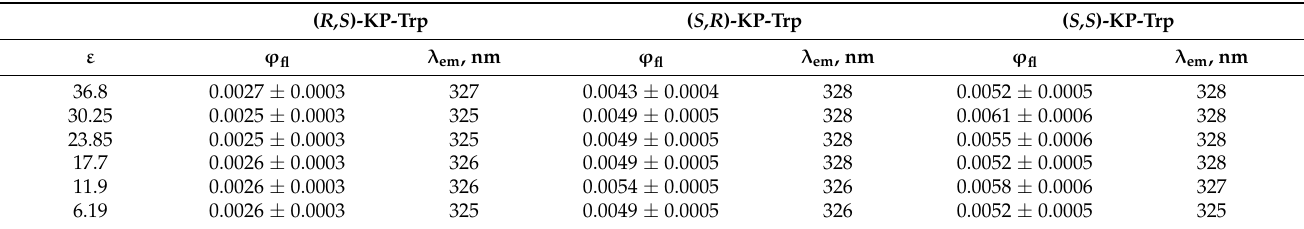
Table 3. Fluorescence quantum yields ( ϕ fl ) and emission maxima ( λ em ) for three optical configurations of the KP-Trp dyad at different dielectric constants of the solvent (mixtures of acetonitrile/ethylacetate).